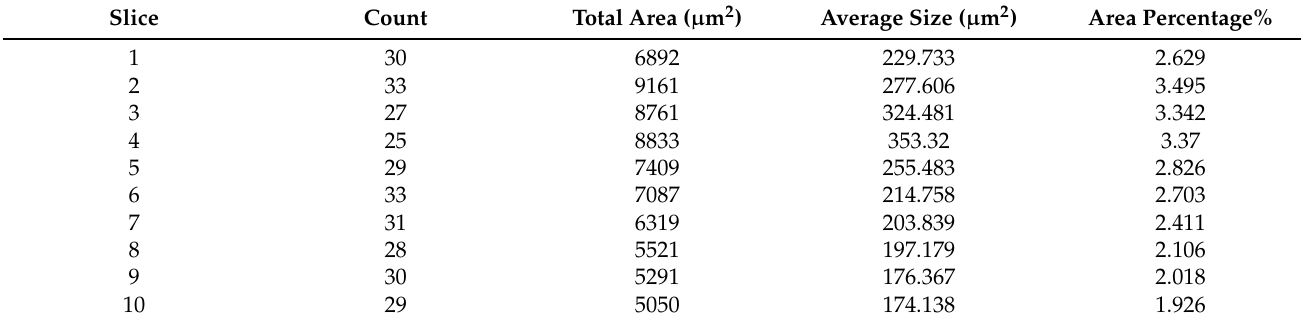
Table 4. Size analysis of segment 1 (mineral 1) in the segmented output.